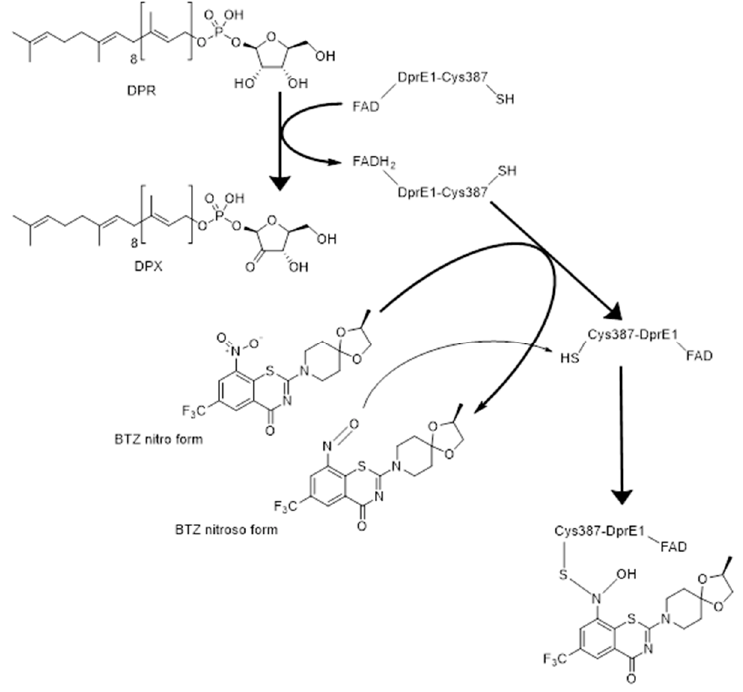
Figure 1. Mechanism of activation of the BTZ043 suicide inhibitor of DprE1.